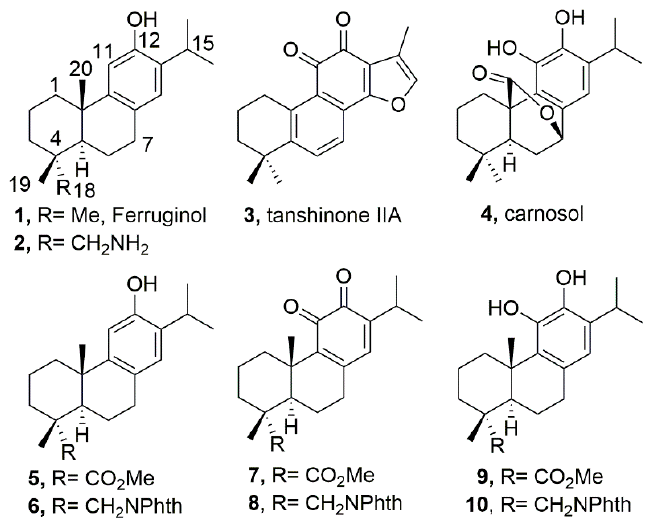
Figure 1. Bioactive abietanes, and tested molecules 1 – 3 and 6 – 10 .